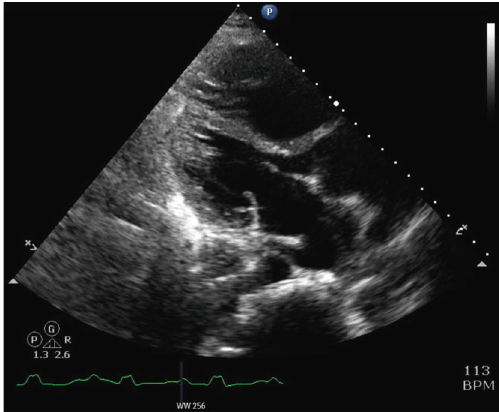
Figure 2: Transthoracic echocardiogram (TTE) demonstrating right sided ventricular